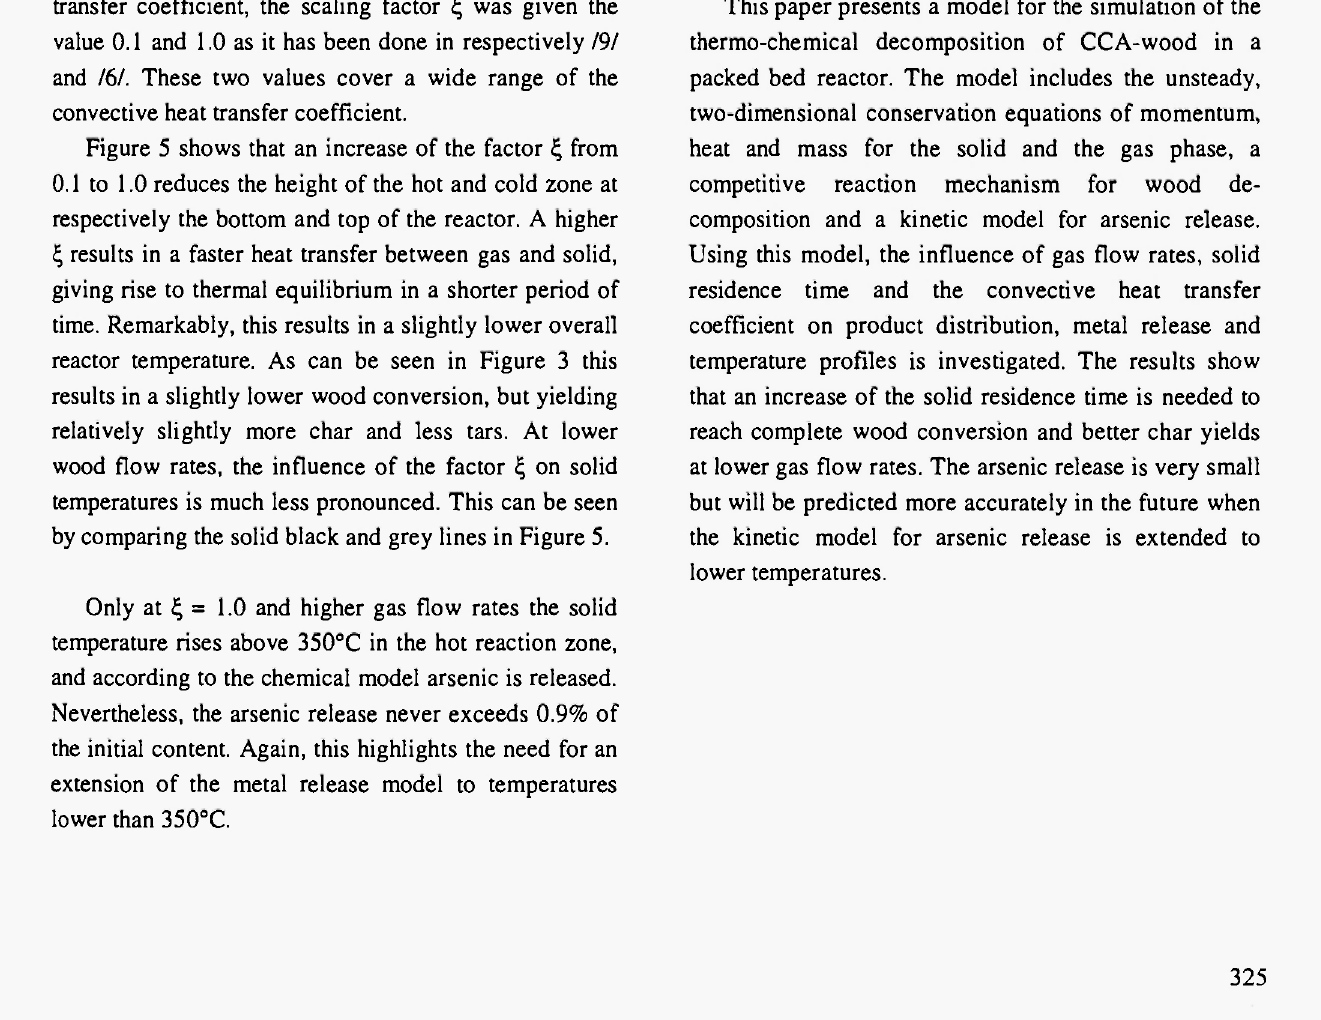
Fig. 4: Product distribution as function of gas flow rate for a wood flow rate of 750 kg/h (black curves) and 500 kg/h (grey curves) for ξ = 1.0